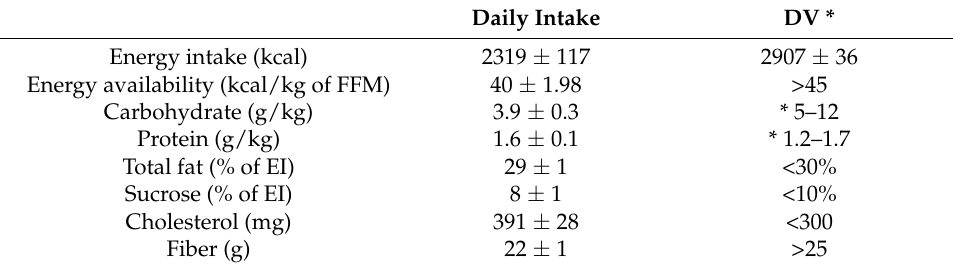
Table 2. Energy, macronutrient, cholesterol, and fiber intake.